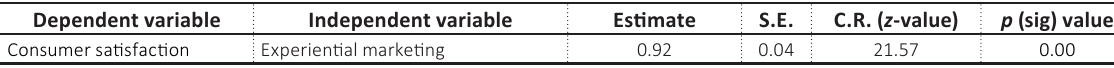
Table 4. Hypotheses